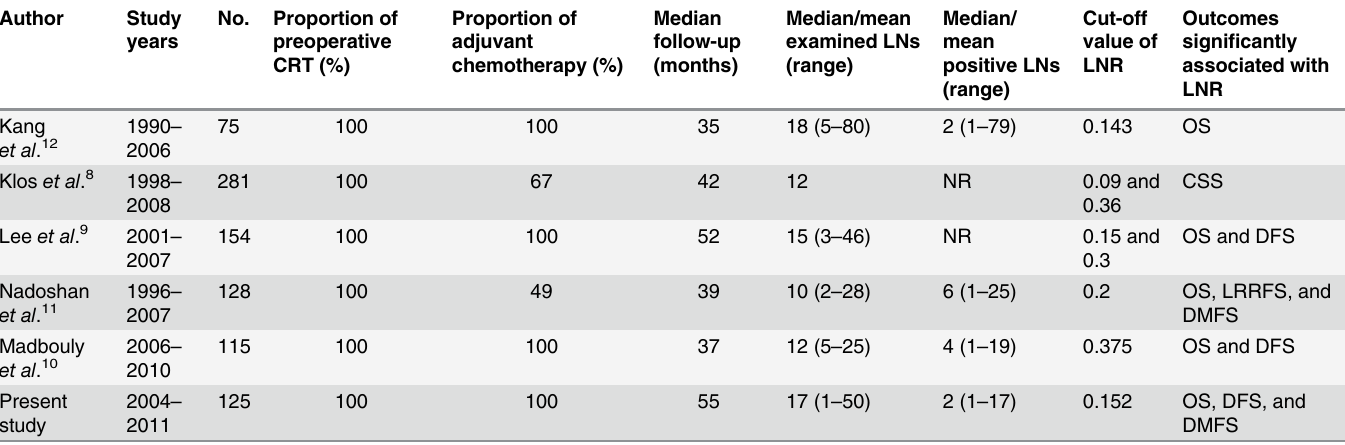
Table 4. Previously reported lymph node ratio studies of rectal cancer patients who underwent preoperative